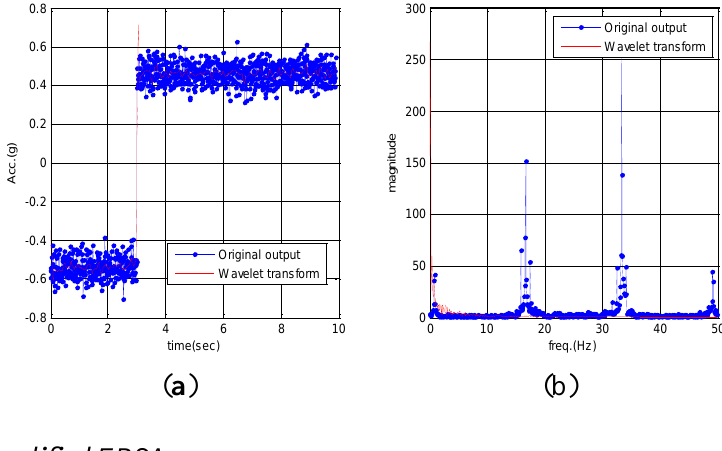
Figure 7. Reconstructed sensor signal. ( a ) time domain. ( b ) frequency